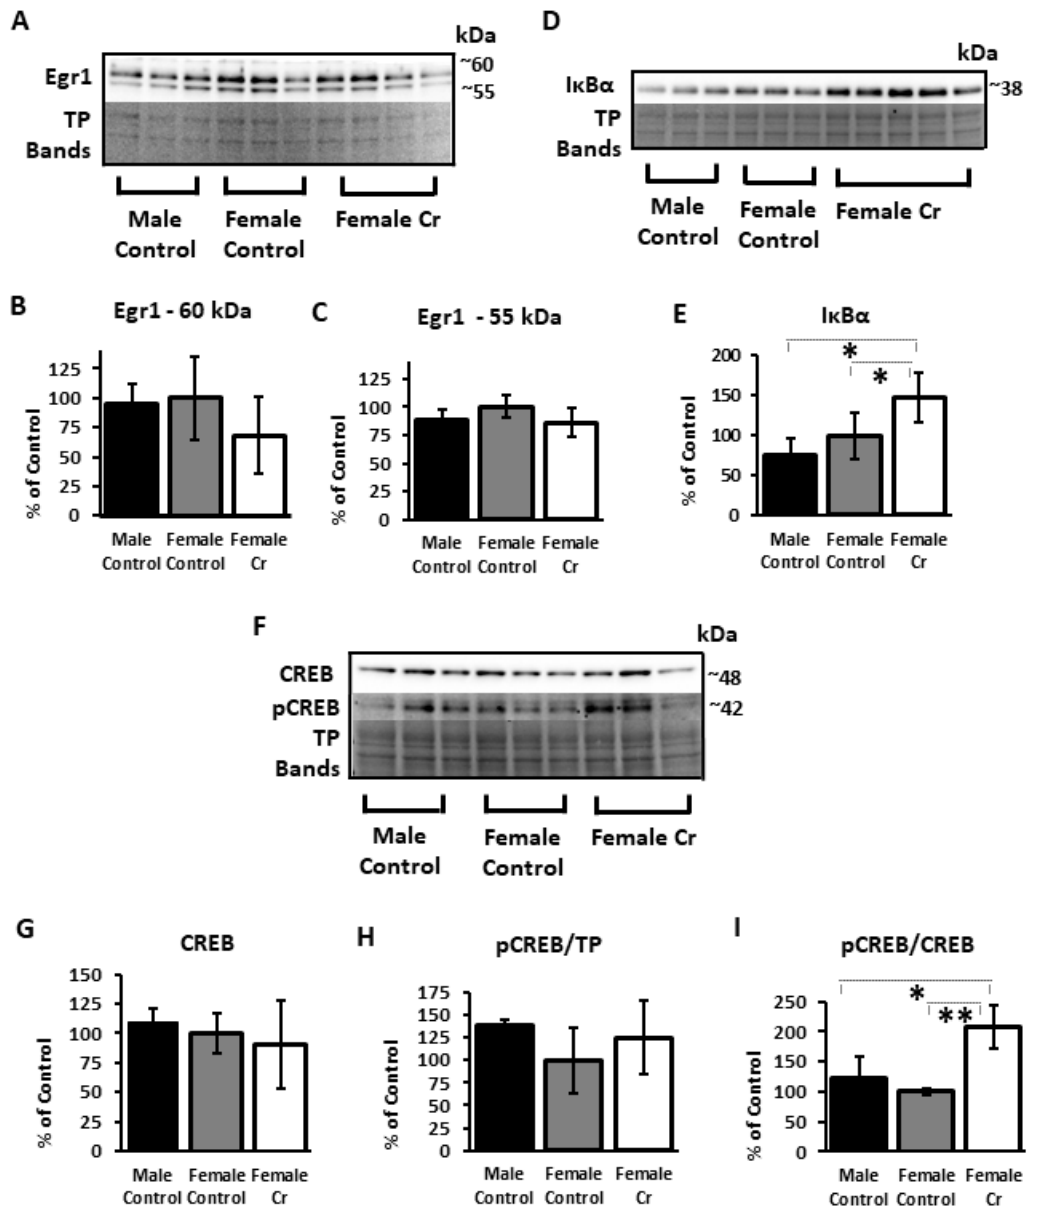
Figure 7. Relative hippocampal levels of transcription factors and related proteins in control and Cr-supplemented 3xTg mice. Representative Western blots detecting ( A ) early growth response 1 (Egr1), ( D ) inhibitor of nuclear factor kappa b, alpha (I κ B α ), ( F ) cAMP response element-binding protein (CREB), and phosphoCREB (pCREB). Total protein (TP) was detected with Ponceau S staining, with representative bands from total protein staining shown to indicate sample loading. Bar graphs depict densitometry values of ( B ) Egr1 at approximately 60kDa and ( C ) 55 kDa, as well as ( E ) I κ B α , ( G ) CREB, and ( H ) pCREB after normalizing to total protein bands and expressed as the percentage change from control means (female control-fed; 100%) ± SD. ( I ) Relative levels of pCREB normalized to CREB. ANOVA or Brown–Forsythe: n = 3–5; * p < 0.05; ** p < 0.01.